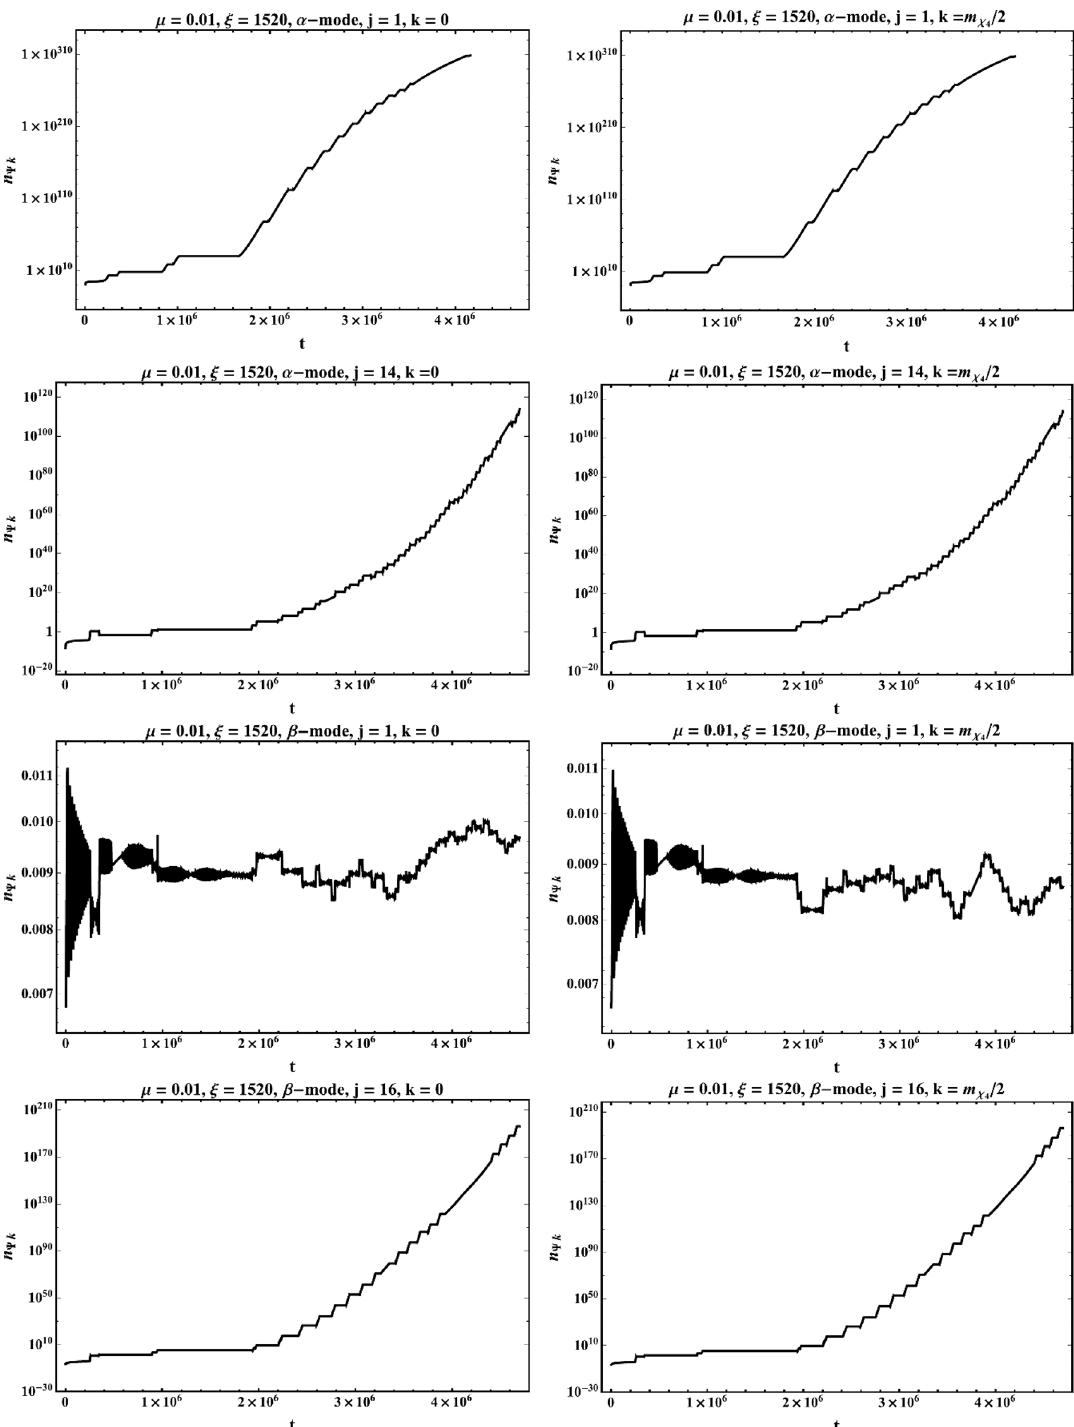
Figure 6 . The time evolution of the logarithm of the number density of various scalar preheat (cid:12)elds, (cid:22)(cid:9) i as a function of time, for (cid:22) = 0 : 01 and (cid:24) = 1520.